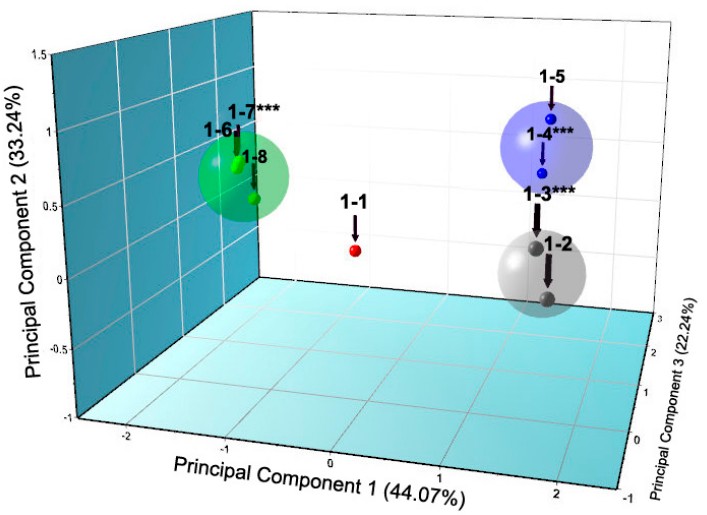
Figure 9. Principal Component Analysis (PCA) analysis of synchrotron (ID31 (now ID22), ESRF, λ = 1.29994 (1) Å, RT) XRPD data of HI crystallized in the presence of 4 ‐ ethylresorcinol. Analysis resulted in four discrete clusters (red, grey, blue and green) corresponding to the four different phases identified P 2 1( γ ), P 2 1( α ) , C 2 and P 2 1( β ) , respectively. Numbers above each element correspond to sample coding (Reproduction of Figure 4 from reference [57]).